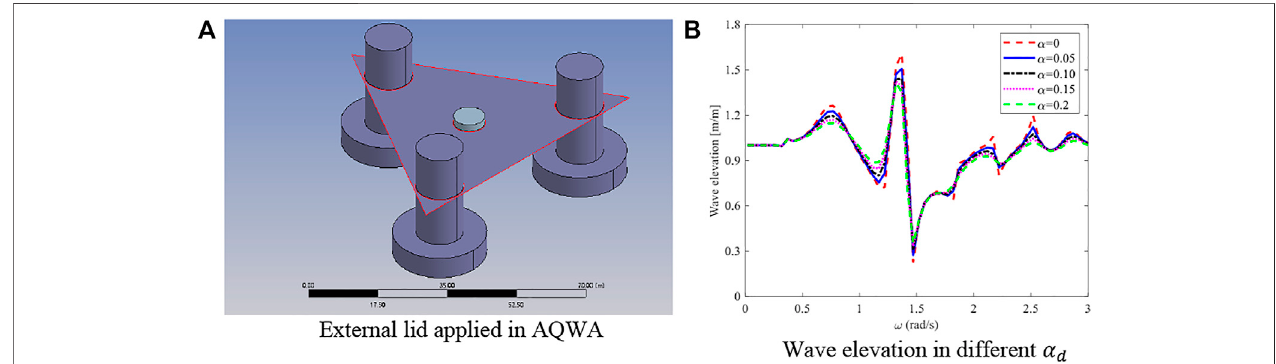
FIGURE 8 | Correction of the arti fi cial viscous damping in AQWA. (A) External lid applied in AQWA. (B) Wave elevation in different α d .